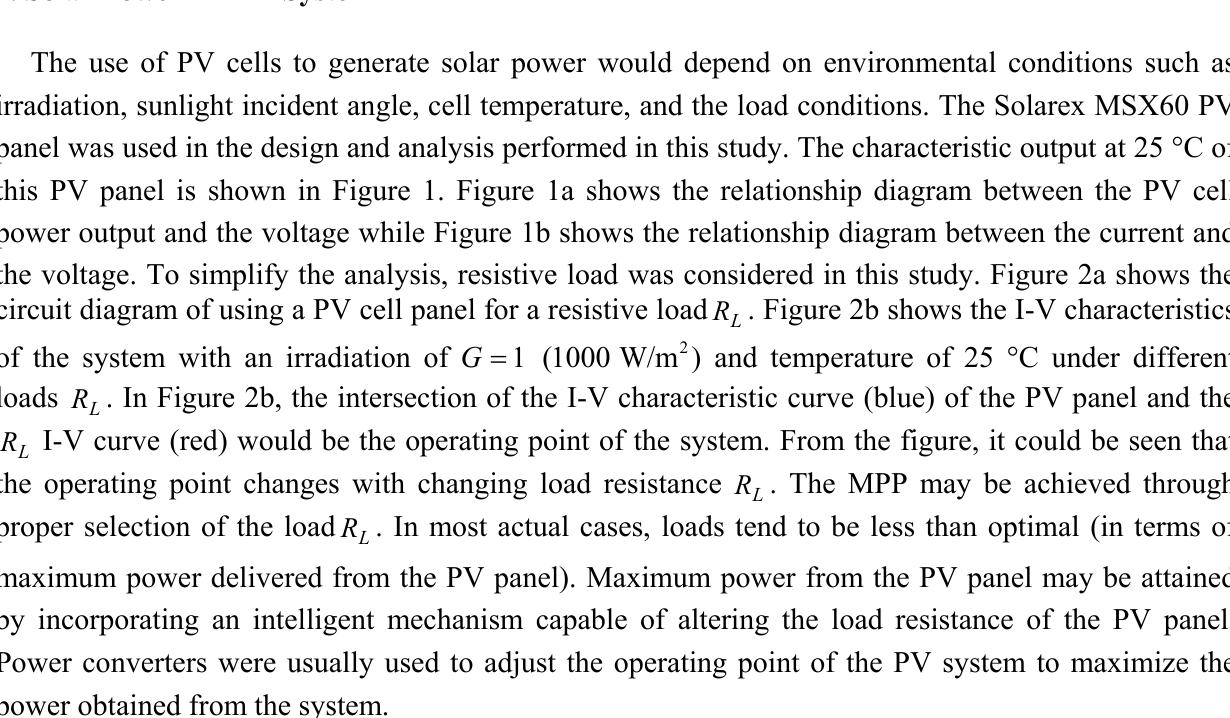
R . In Figure 2b, the intersection of the I-V characteristic curve (blue) of the PV panel and the L R I-V curve (red) would be the operating point of the system. From the figure, it could be seen that L